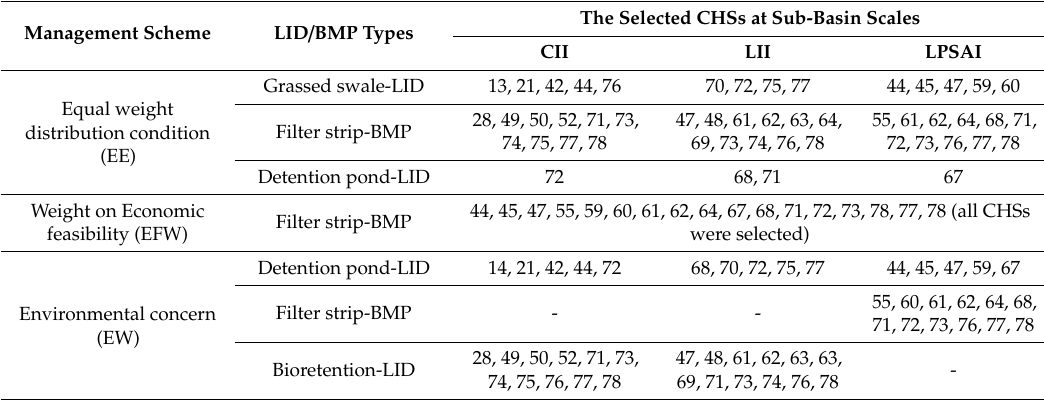
Table 8. The selected individual LID / BMP at CHSs using spatial targeting methods (CII, LII, and LPSAI) associated with three di ff erent weighting schemes (EE, EFW, and